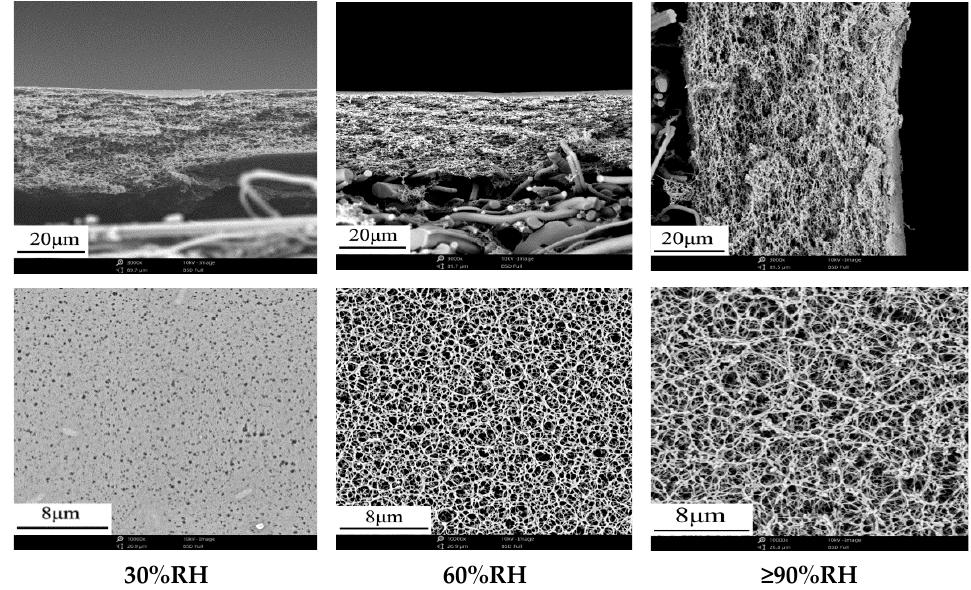
Figure 7. Effect of ambient humidity on the cross-section and surface microstructure of membranes. Table 8. The properties of membrane prepared under different ambient humidity.